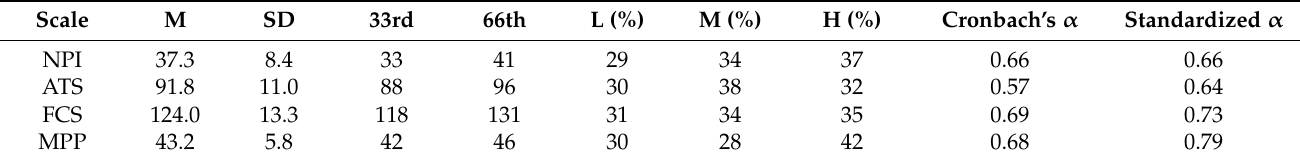
Table 6. Means (M), standard deviations (SD), percentile cut-points (33rd and 66th), percentage of participants in each group (L = low attitude; M = moderate attitude; H = high attitude), and reliability of attitude scales: Natural product interest (NPI), attitudes toward sustainability in general (ATS), food consumption sustainability (FCS), and mountain pasture practice scale